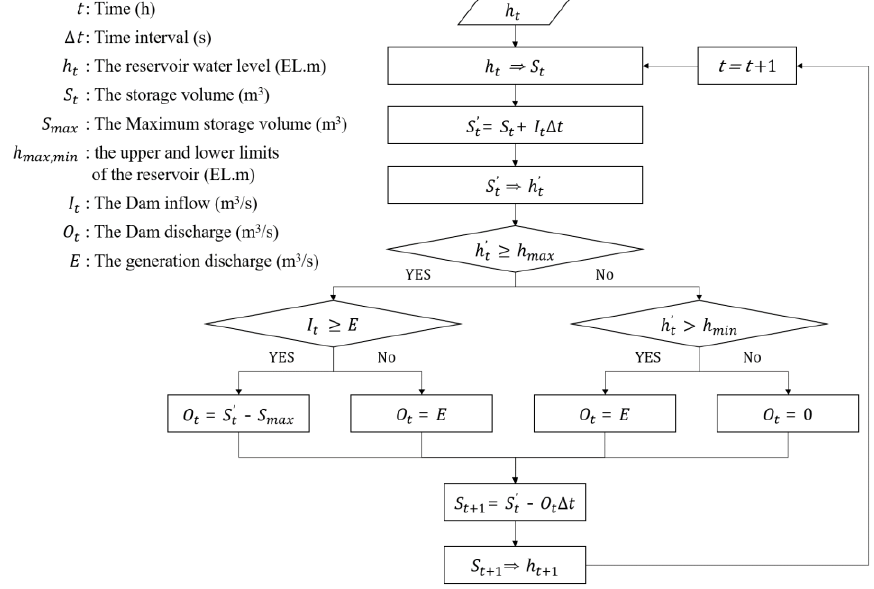
Figure 9. The flow chart of the Auto ROM algorithm for the Hwanggang Dam reservoir.